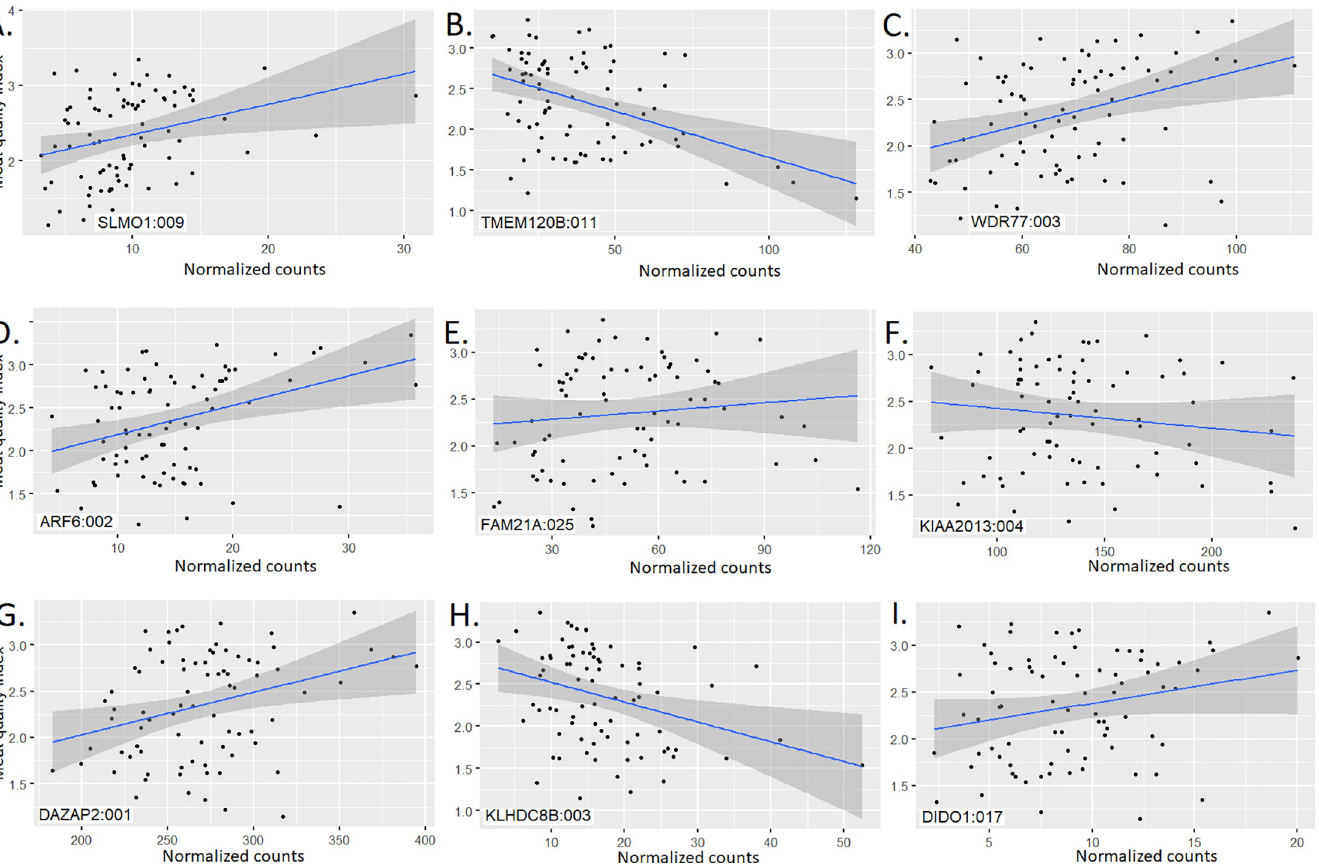
Fig 5. Scatter plots with regression lines and 95% confidence intervals for exon normalized counts and meat quality index for the top nine associated genes.